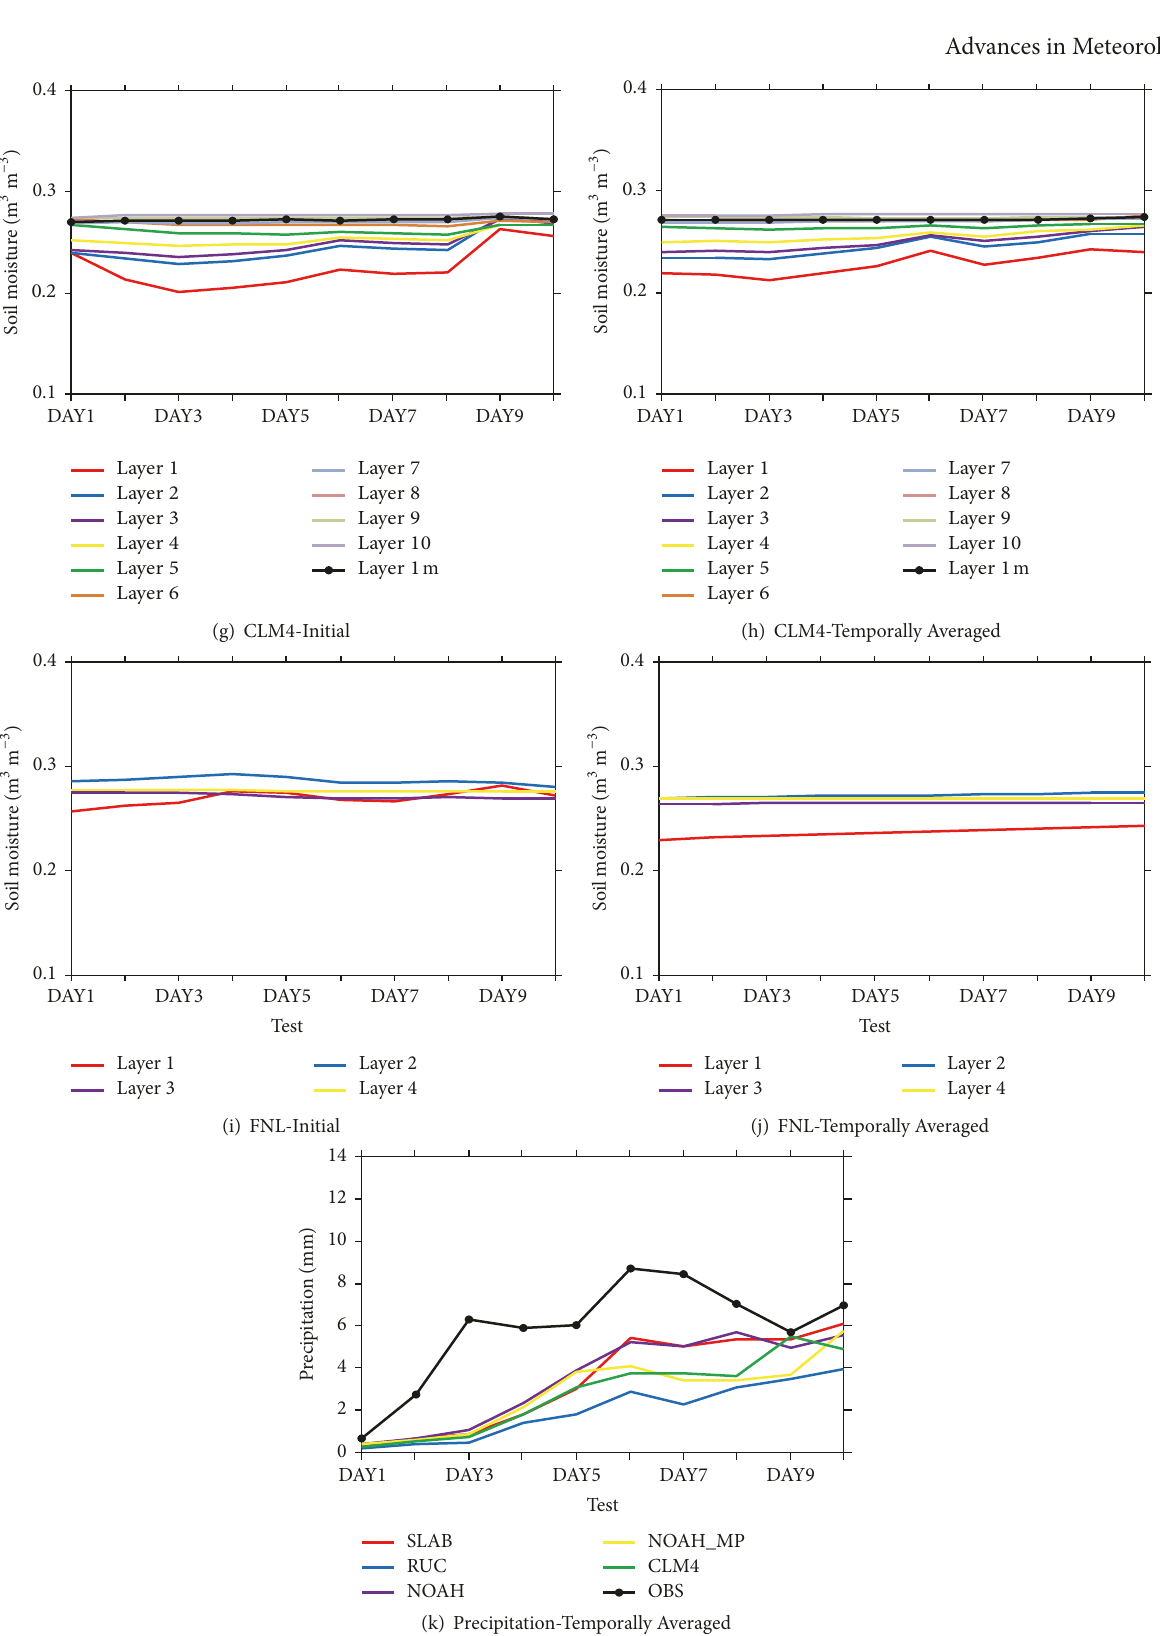
Figure 8: (a, c, e, g, and i) Domain A3-averaged initial soil moisture contents (unit: m 3 m −3 ) and (b, d, f, h, and j) soil moisture variations (unit: m 3 m −3 ) for the LSSs over time for the following soil layers: RUC (Level 1: 0 cm; Level 2: 5cm; Level 3: 20 cm; Level 4: 40cm; Level 5: 160